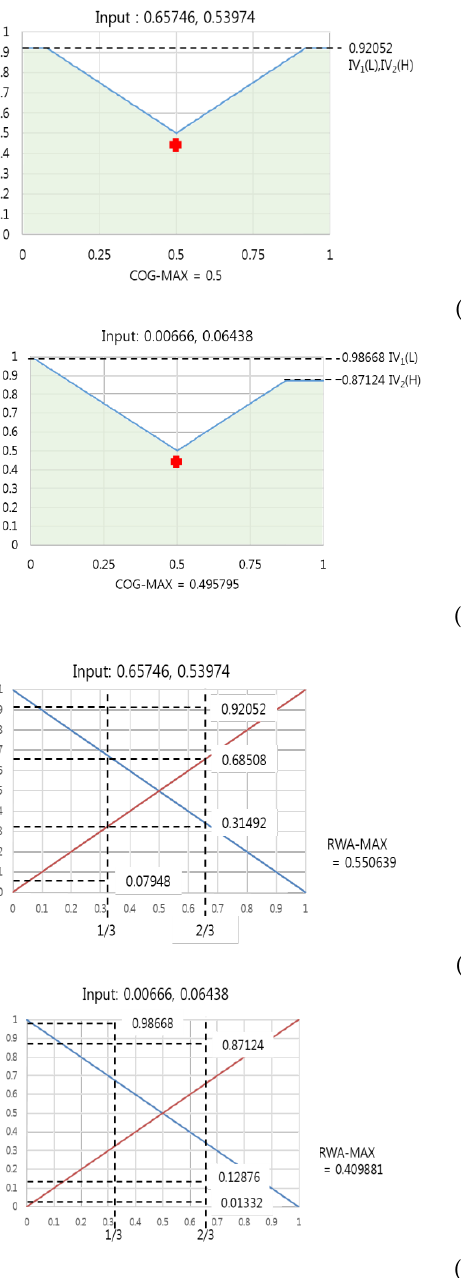
Figure 9. Comparison examples of COG and RWA output values: ( a ) COG output value from fit